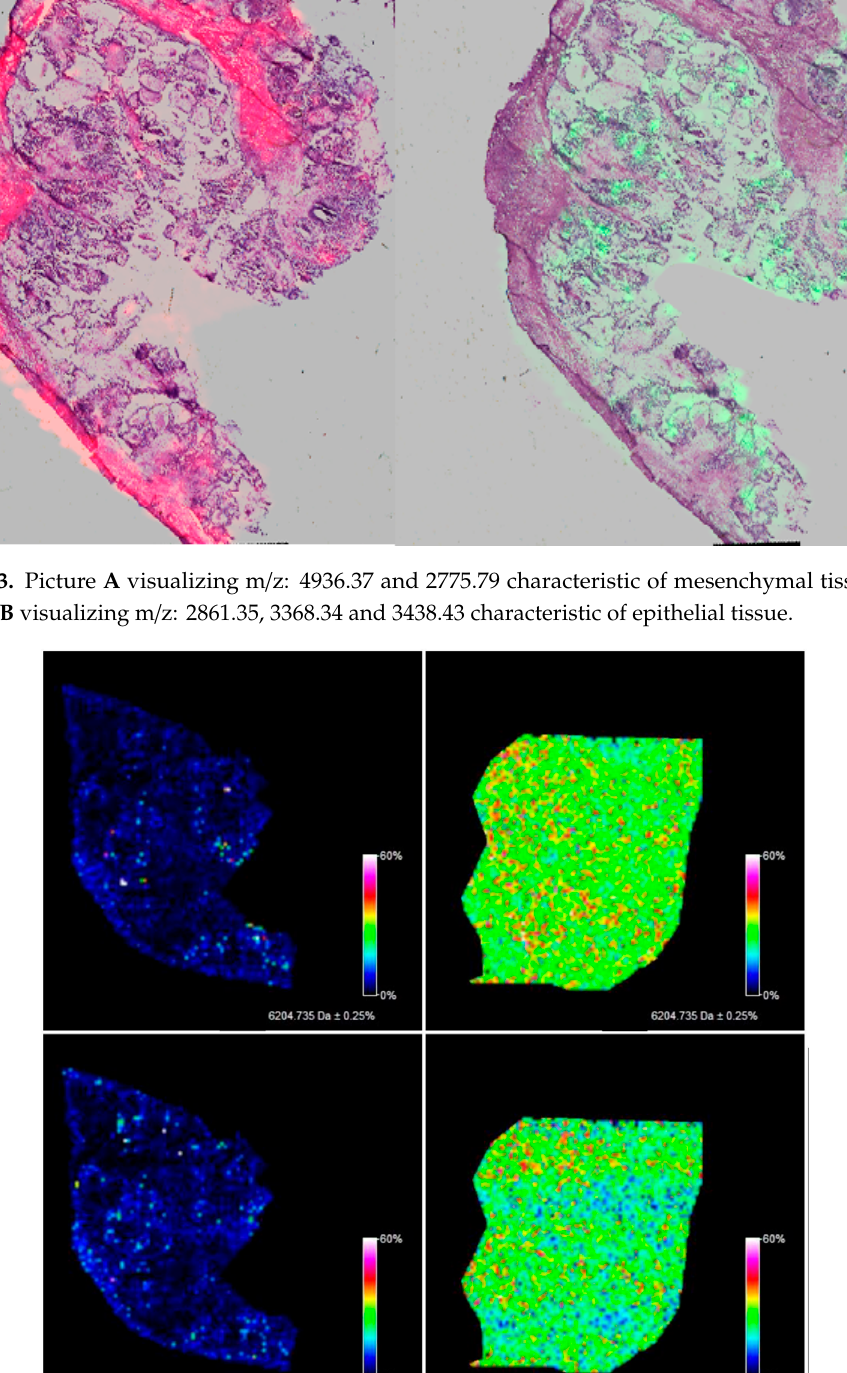
Figure 4. Visualization of the peaks (m/z: 6204.735, 8453.171, 10,146.87, 10,092.39) differentiating the borderline ovarian tissue (left) from the ovarian fibrothecoma tissue (right) based on the average spec- tra. Immunohistochemistry (IHC)